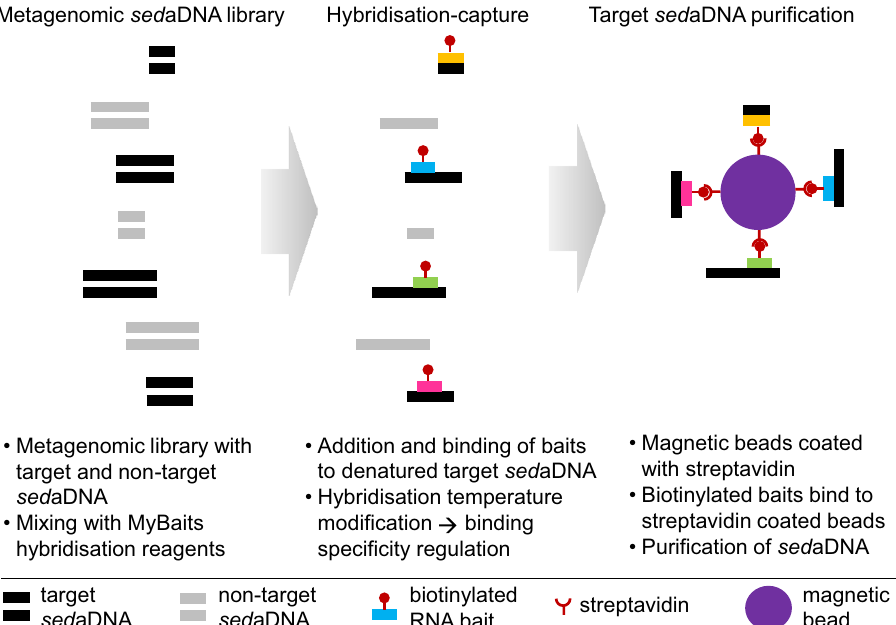
Figure 1. Schematic of hybridisation capture applied to marine sedimentary ancient DNA ( sed aDNA). The three main steps are the preparation of a metagenomic sed aDNA library, hybridisation capture using RNA baits (in this study: Planktonbaits1 and HABbaits1) that are biotinylated, which enables binding of baits to streptavidin-coated magnetic beads (multiple baits per bead possible, schematic not to scale). For further technical details see Methods [and 12,17